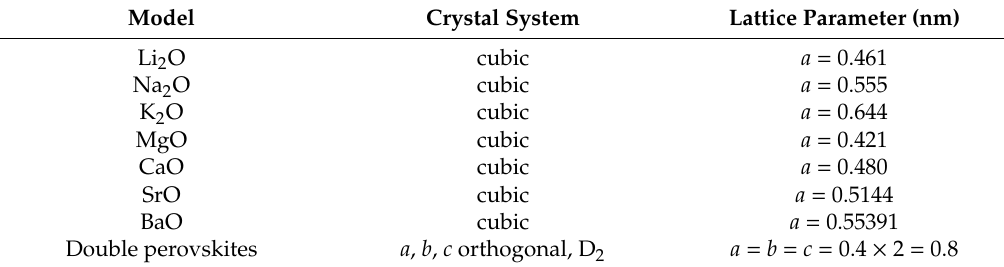
Table 2. Lattice parameters used for